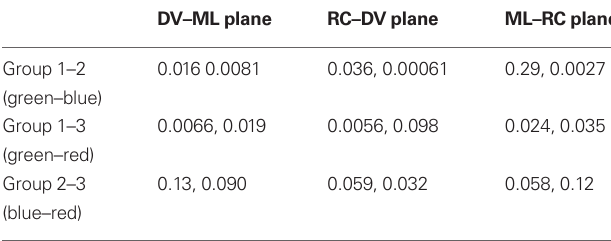
Table 3 | Significance levels for 2D K–S test applied on distribution of types obtained by the AVPSD method (monkeys H, V).